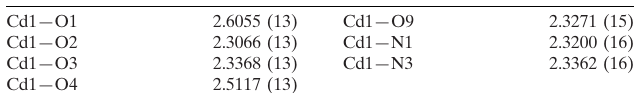
Selected bond lengths (A ˚ ).